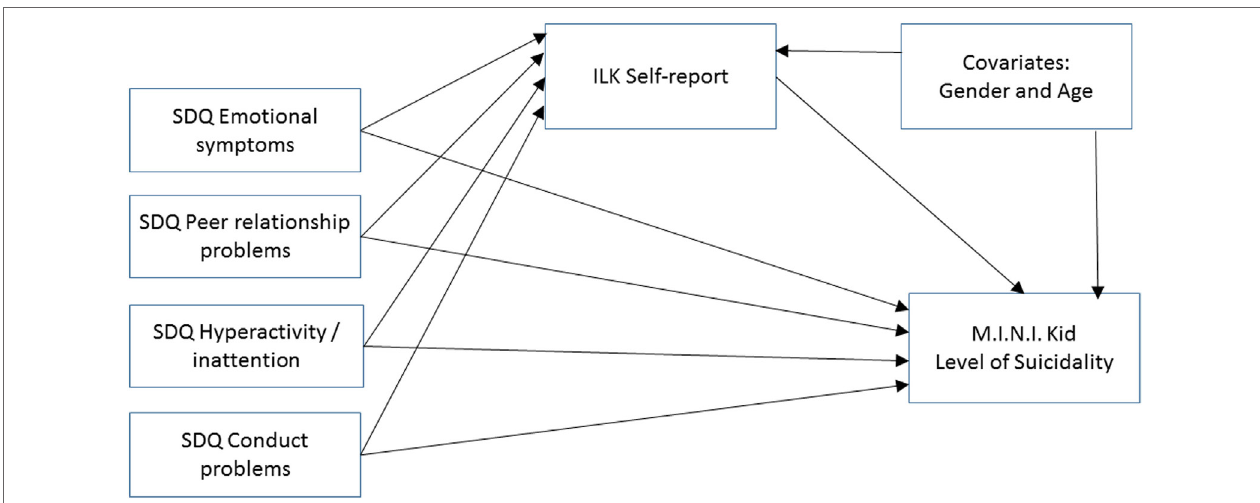
FigUre 1 | Our hypothetical mediational model: the relationship between psychopathology and level of suicidal risk (suicidal risk) as mediated by self-reported quality of life. Abbreviations: ILK, Inventar zur Erfassung der Lebensqualität von Kindern und Jugendlichen; SDQ, Strengths and Difficulties Questionnaire; MINI KID, Mini International Neuropsychiatric Interview